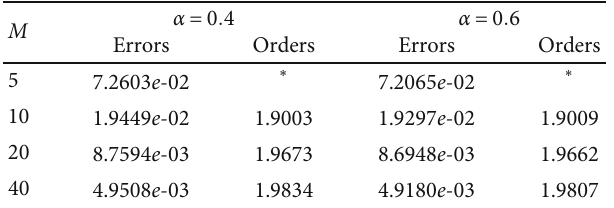
Table 2: The errors and convergence orders in spatial direction by using L-FEM.